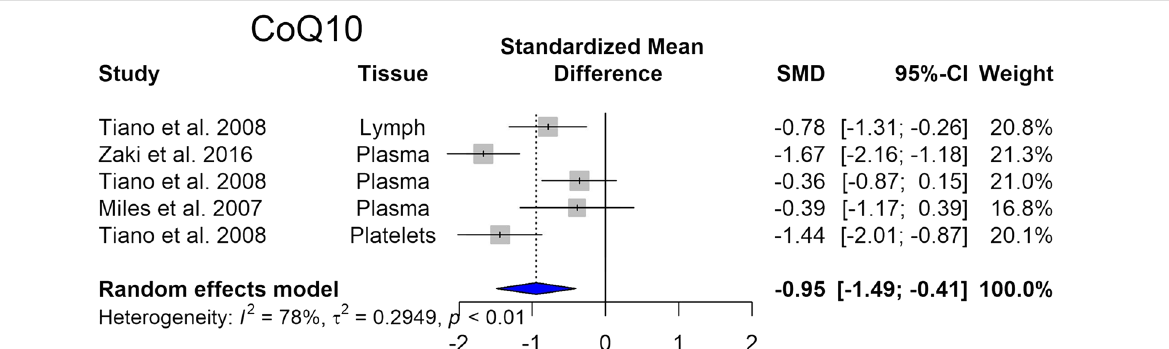
Fig. 3 Changes in CoQ10 in Down syndrome. Forest plot showing relative weights, standardized mean difference (Hedges’ g) with confidence intervals. Overall average effect size is displayed by filled